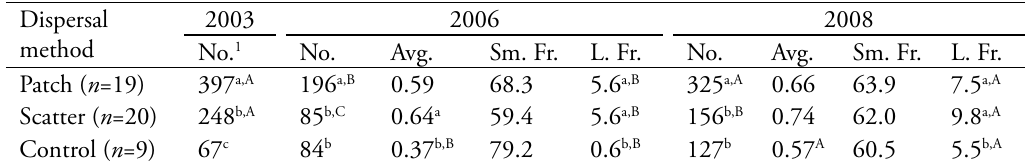
Table 3. Mean number of lichen fragments, average size of the lichen fragments (cm 2 ), and the percentage of small (<0.5 cm 2 ) and large lichen fragments (>2 cm 2 ) in the patch, scatter and control plots in 2003, 2006 and 2008. Different lower case letters within columns indicate significant between- treatment differences (Tukey’s test: P <0.05); different capital letters within lines indicate signifi- cant between-year differences (Paired t -test: P